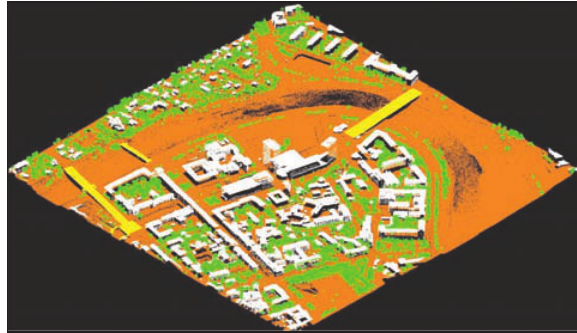
Fig. 1. DSM fragment of city Vilnius central